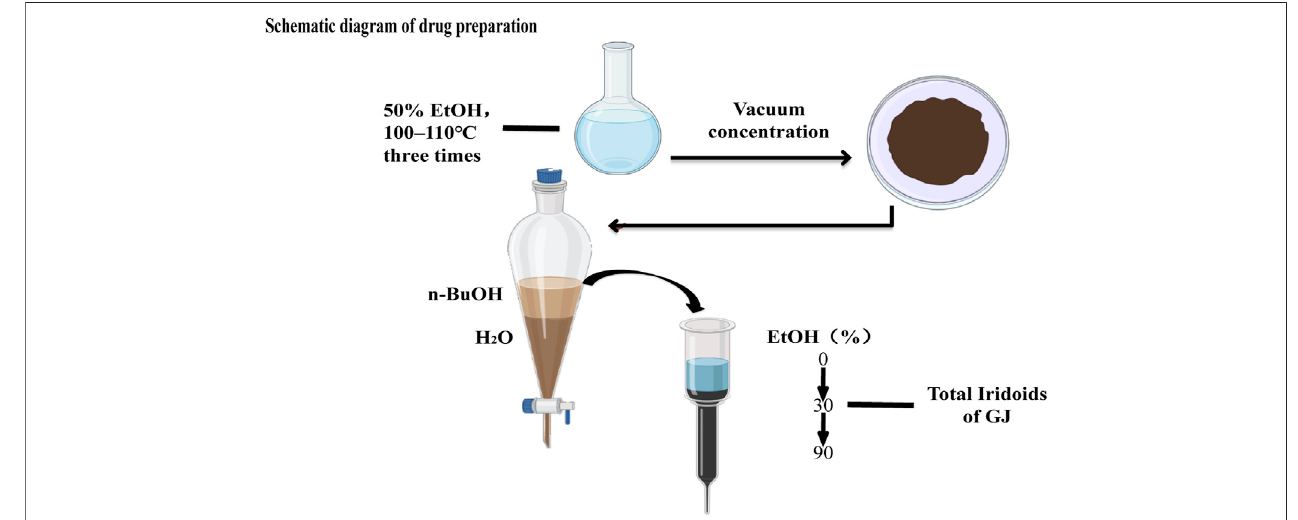
FIGURE 1 | Schematic diagram of drug preparation of total iridoids of